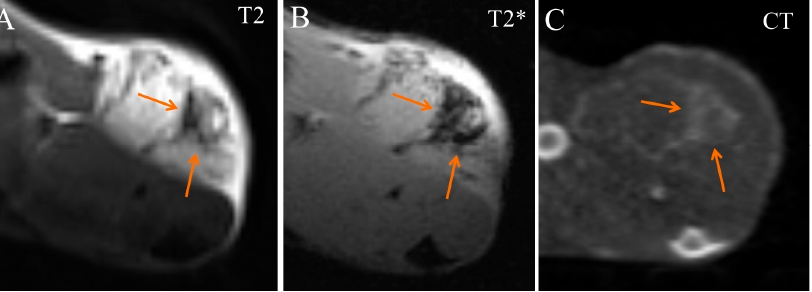
Figure 8. Transversal images of Ca755 mammary carcinoma. ( A ) T2 MRI 50 min post injection of Fe 3 O 4 @Au; ( B ) T2* MRI 50 min post injection of Fe 3 O 4 @Au; ( C ) CT image 65 min post injection of Fe 3 O 4 @Au. Arrows mark the enhanced area of the tumor.